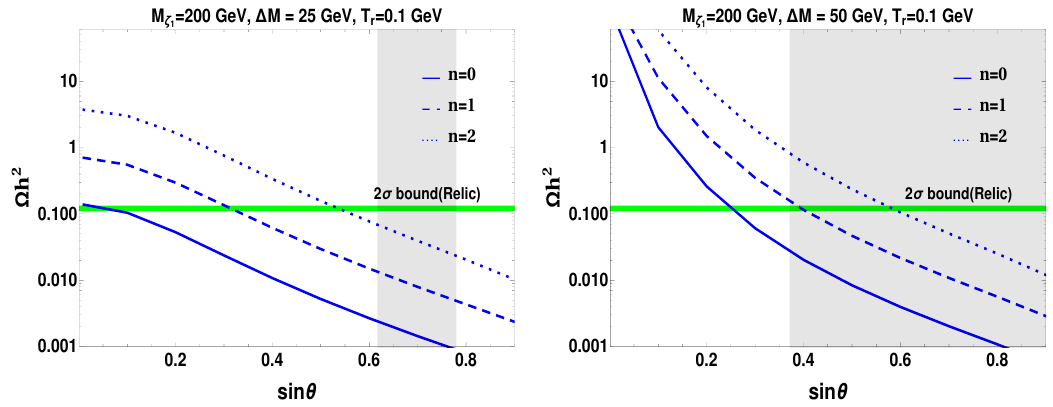
Figure 4 . Relic abundance of the DM as a function of the mixing angle between the singlet and doublet is shown considering both standard (solid line) and non-standard (dashed and dotted lines) thermal history of the Universe, for M ζ = 200 GeV with (left) ∆ M = 25 GeV and (right) 1 ∆ M = 50 GeV. The disfavored region from the spin independent direct detection constraints are denoted by respective shaded region. Here we have considered T r = 0 . 1 GeV.